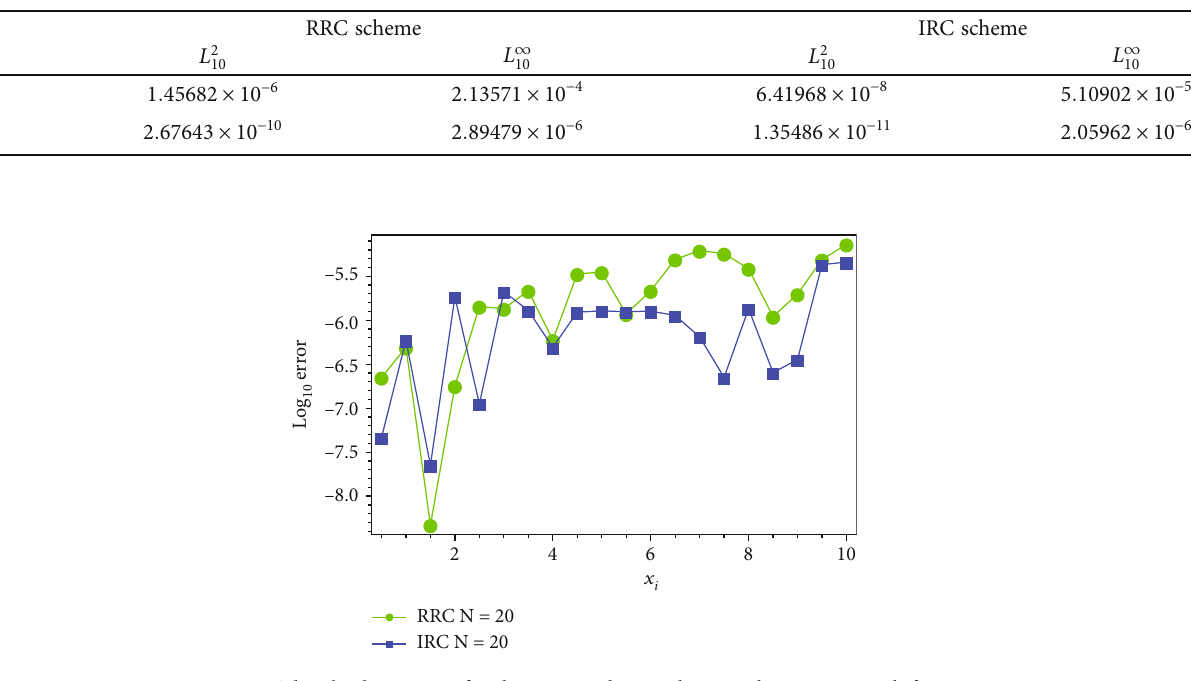
Table 5: Comparing the L 2